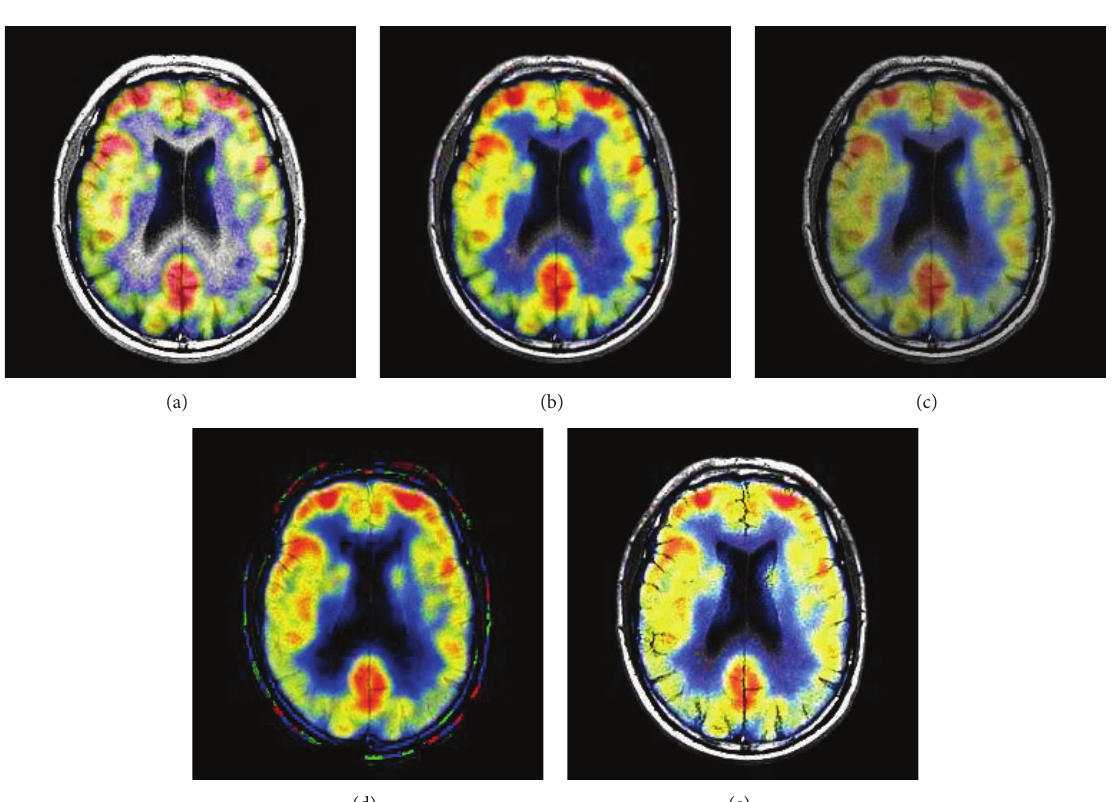
Figure 1: Original MRI and PET images: (a)–(c) MRI; (d)–(f) PET.